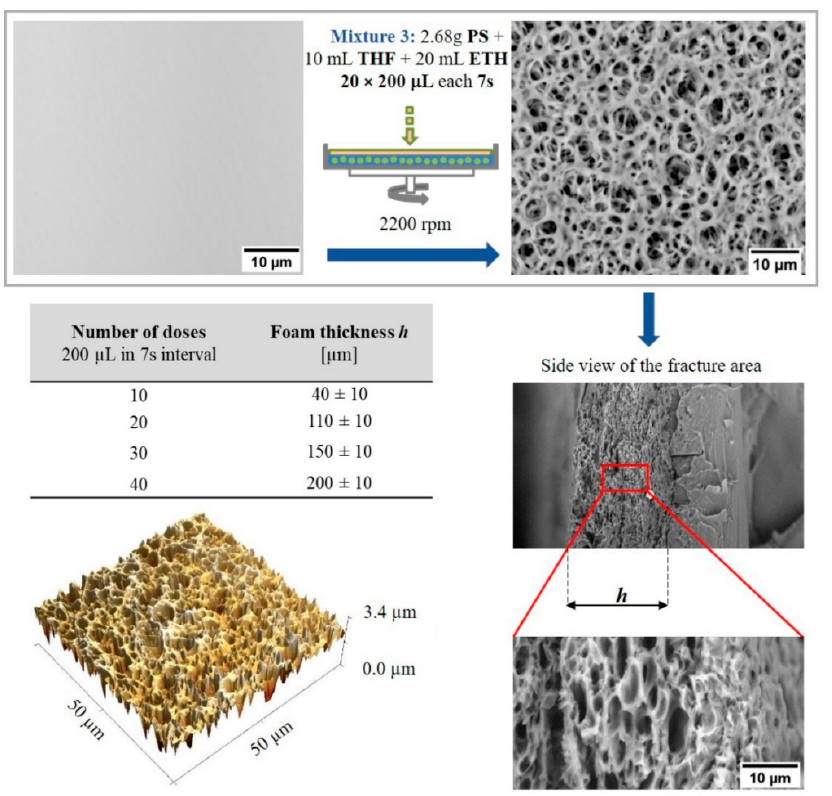
Figure 3. Porous PS layer prepared by time-sequenced phase separation (inversion) from a solvent mixture containing PS. 3D image obtained using AFM. Other images from SEM.